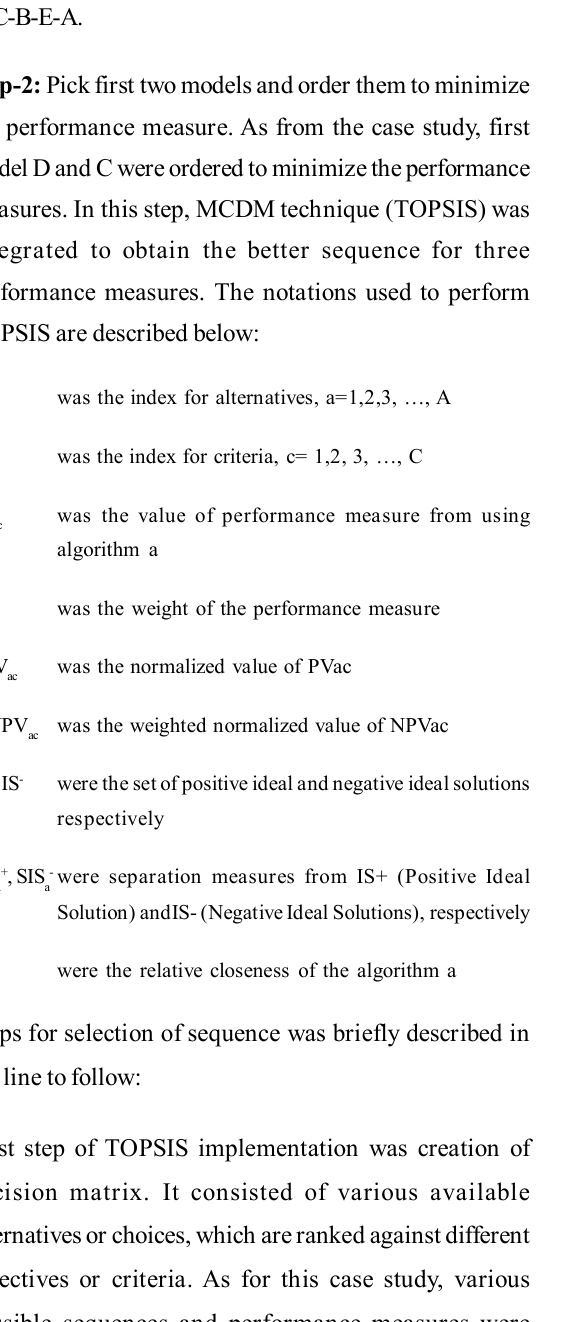
TABLE 5. POSITIVE IDEAL SOLUTION AND NEGATIVE IDEAL